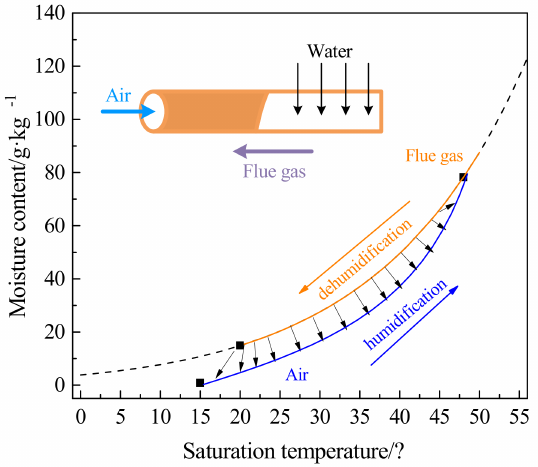
Figure 6. Mass and heat transfer process in the ceramic